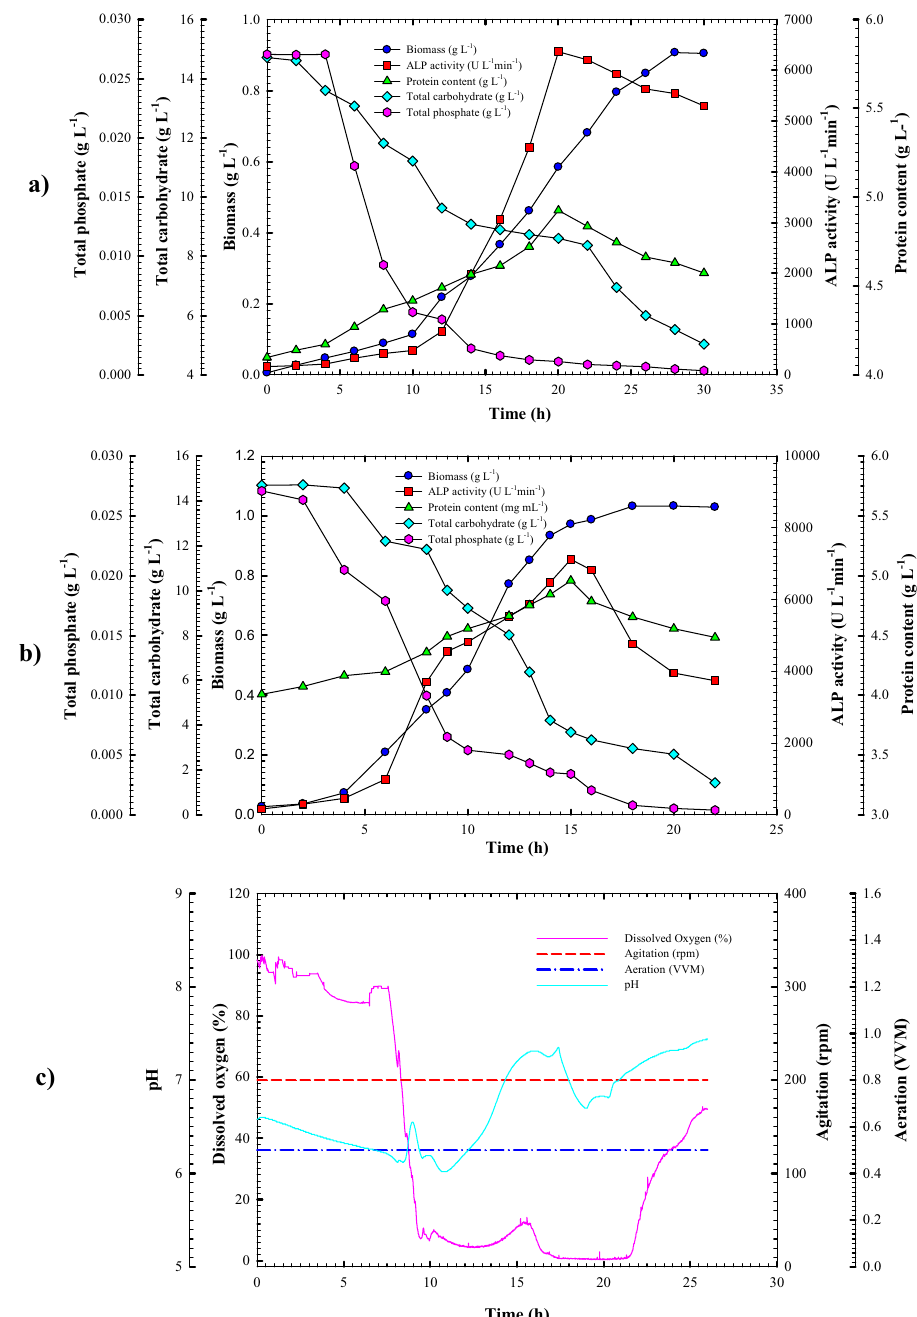
Figure 6. Monitoring of Lysinibacillus sp. strain APSO growth and ALP productivity in (a) a shake-flask scale cultivation condition and (b) a 7 L stirred-tank bioreactor under uncontrolled pH conditions. (c) Online data (DO, agitation, airflow rate, and pH) as a function of time during batch fermentation in the bioreactor under uncontrolled pH